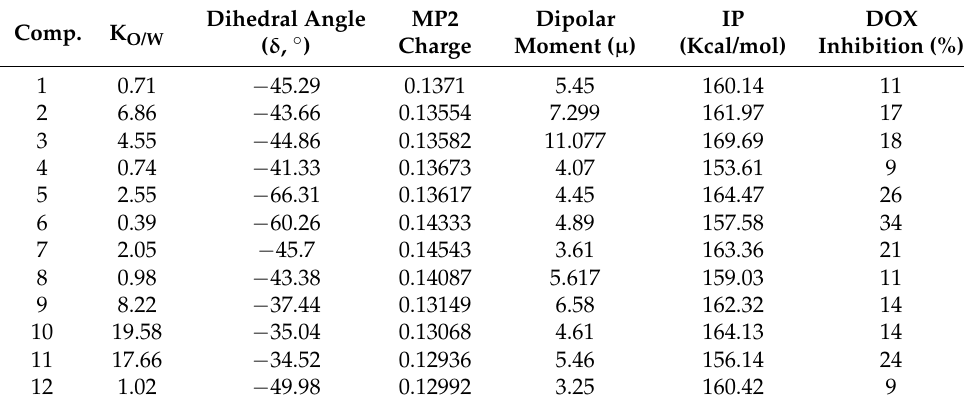
Table 1. Nitrone parameters used for multivariable analysis.